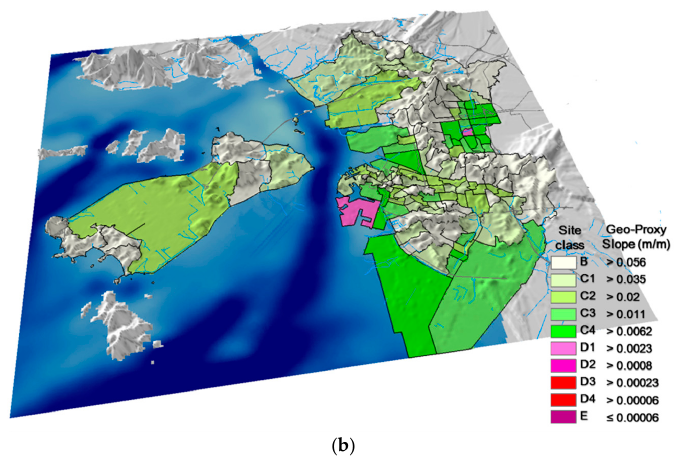
Figure 12. 3D view of seismic zonation with administrative sub-units by computing the average T G and the proposed geo-proxy for each unit in the study area of Incheon: ( a ) T G ; ( b ) slope (proposed criterion).